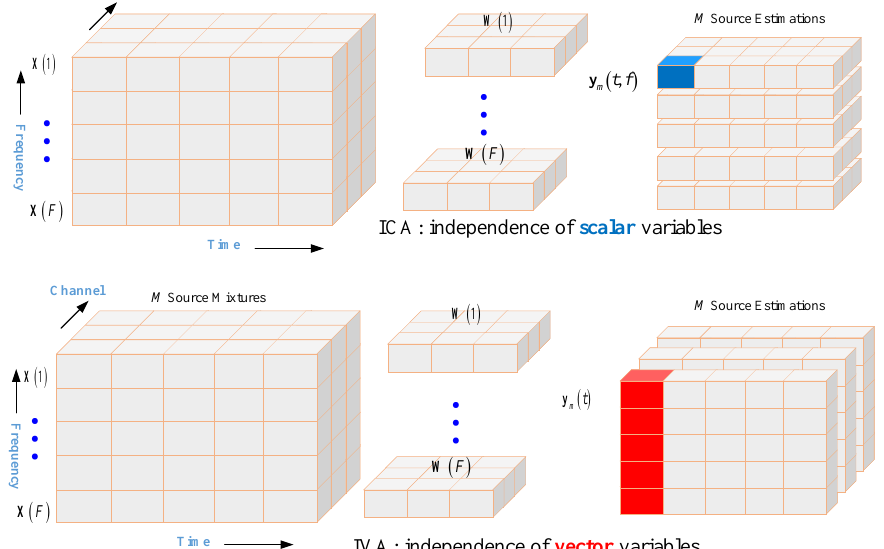
Figure 3. IVA mechanism versus ICA